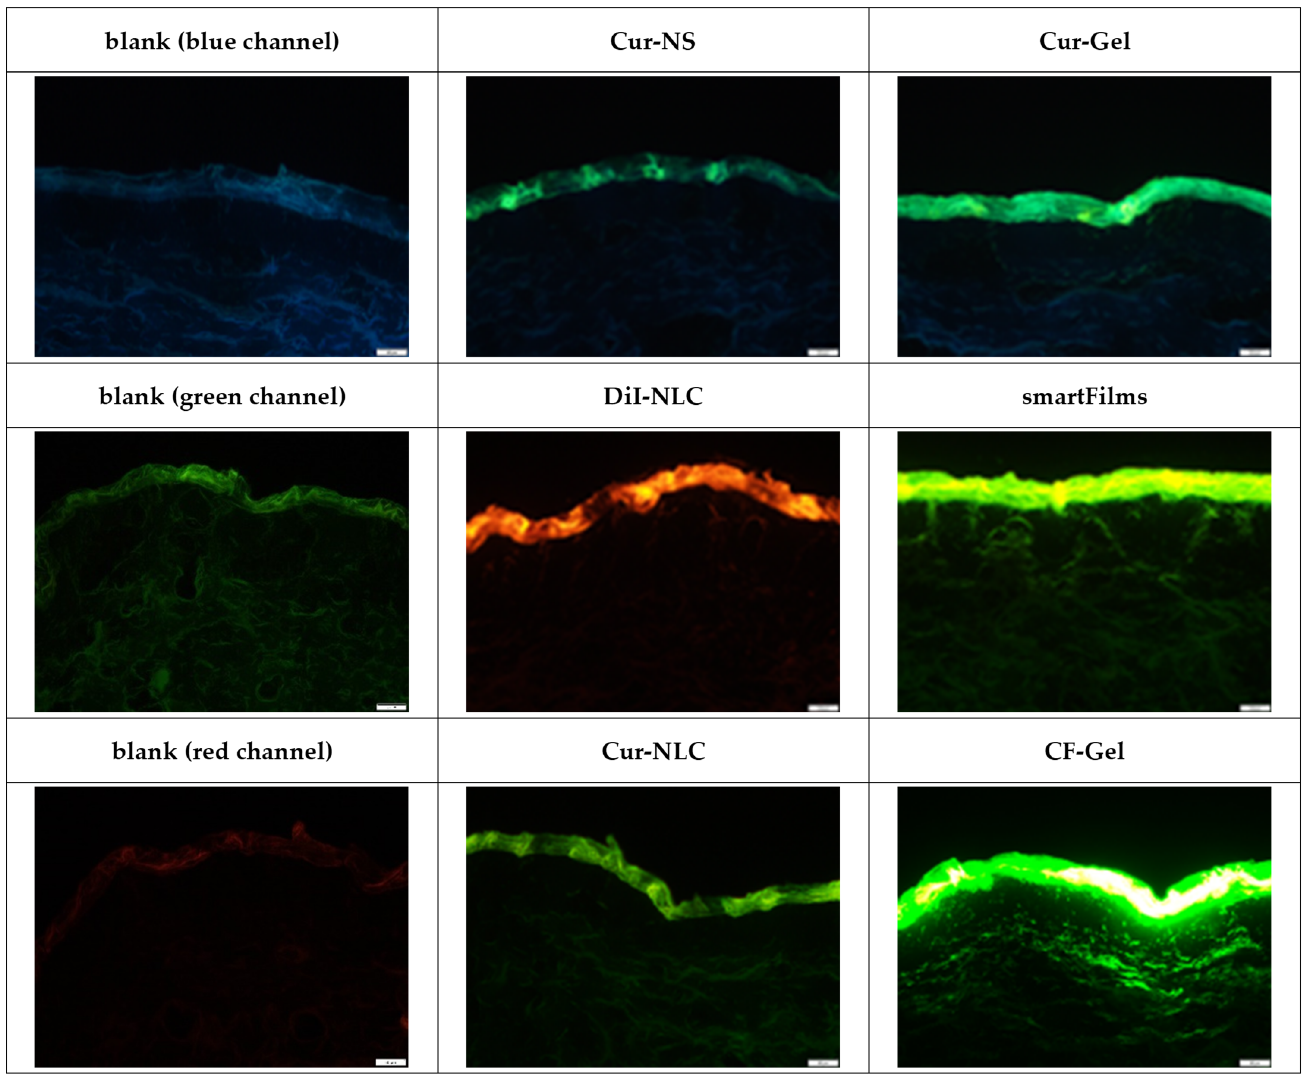
Figure 3. Microscopic images of skin sections treated with different formulations (cf. Table 2) obtained by inverted fluorescence microscopy (magnification 200-fold, scale bar = 50 µm).